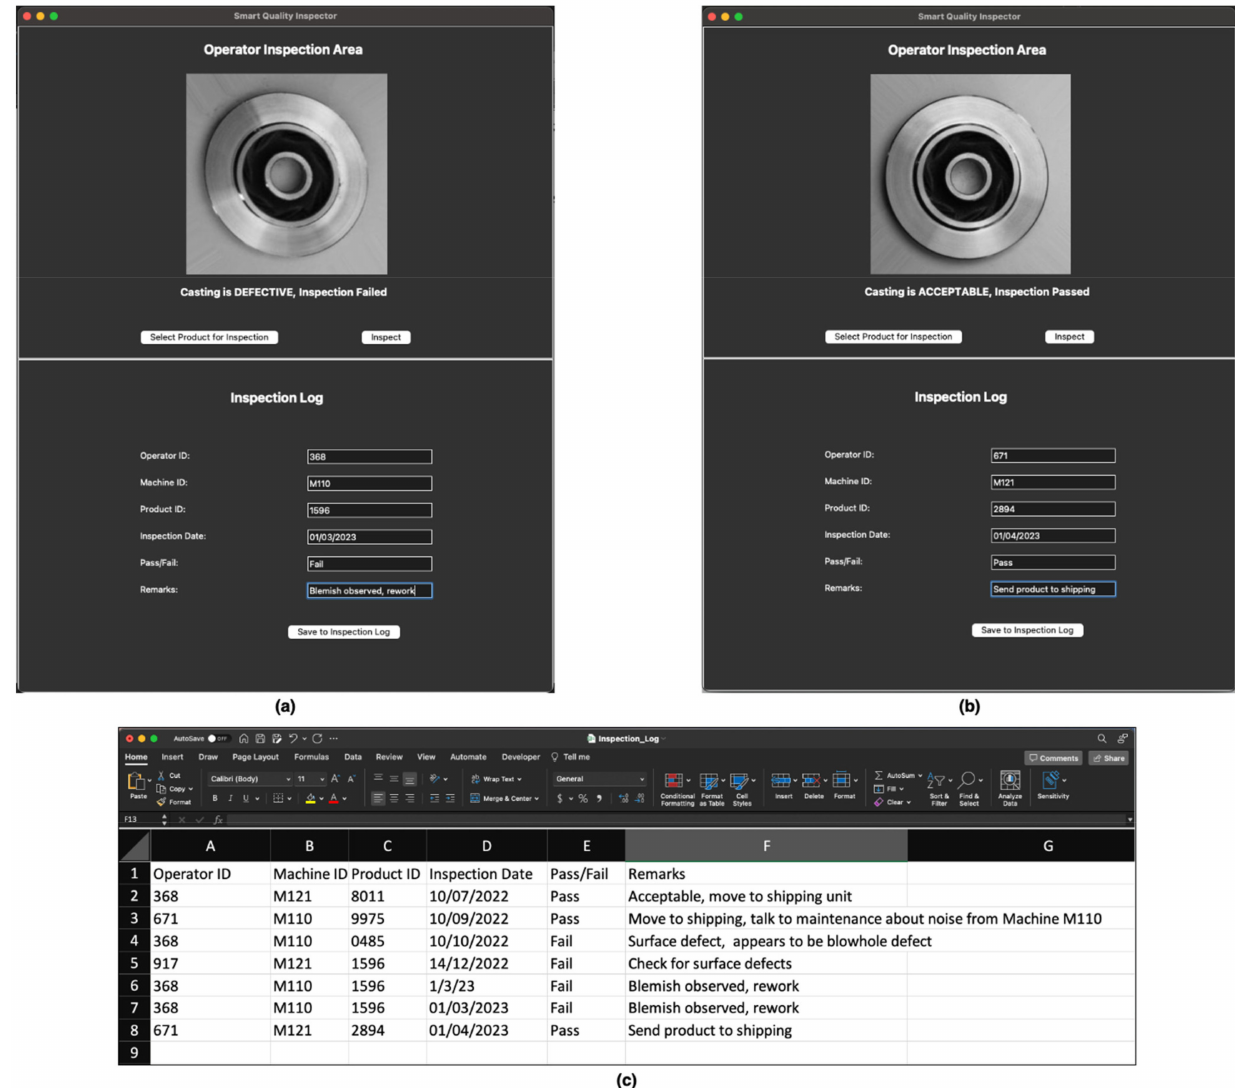
Figure 9. Shop floor application for Smart Quality Inspection. ( a ) shows the inspection of a defective product, ( b ) shows the inspection of an acceptable product, and ( c ) shows the results of the inspection documented in the inspection log (spreadsheet opened in Microsoft